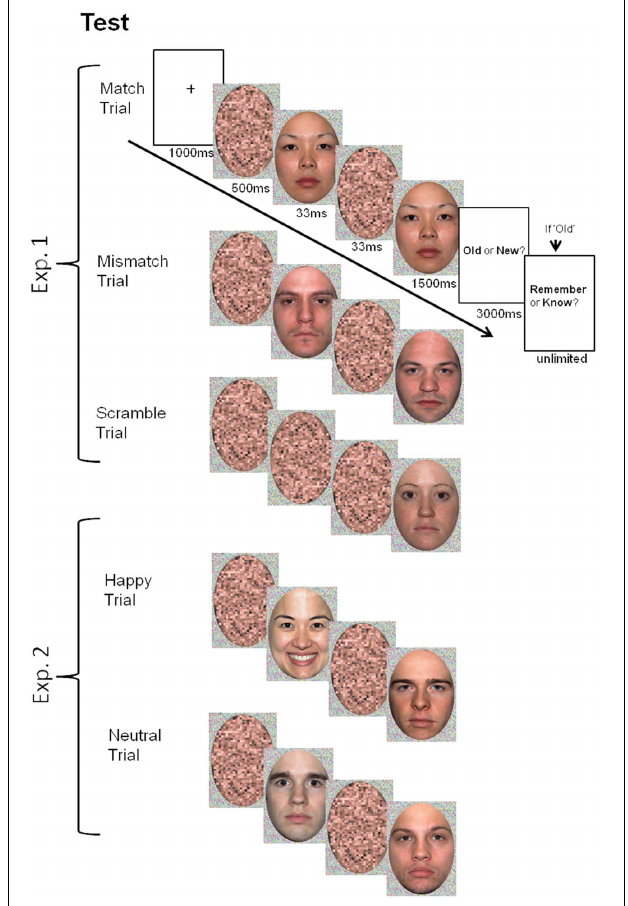
FIGURE 1 | Illustration of event sequences and trial types for each